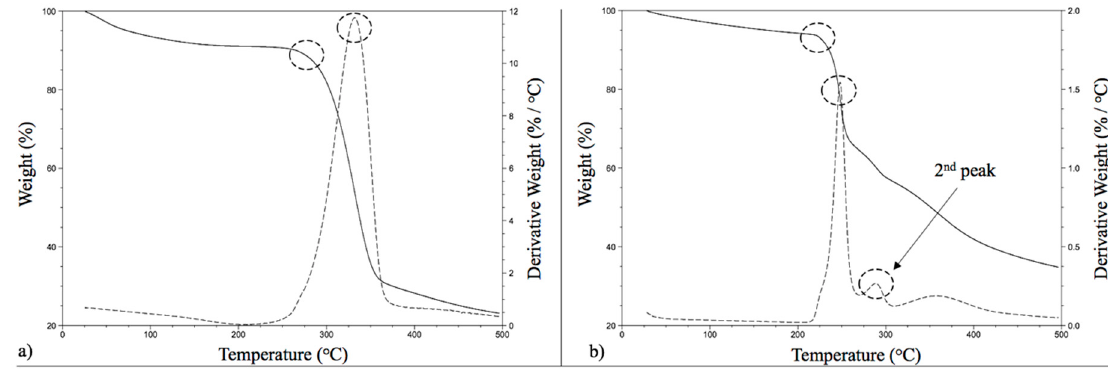
Figure 2. Representative TGA and DTGA curves of CNF ( a ) and CNC ( b ).